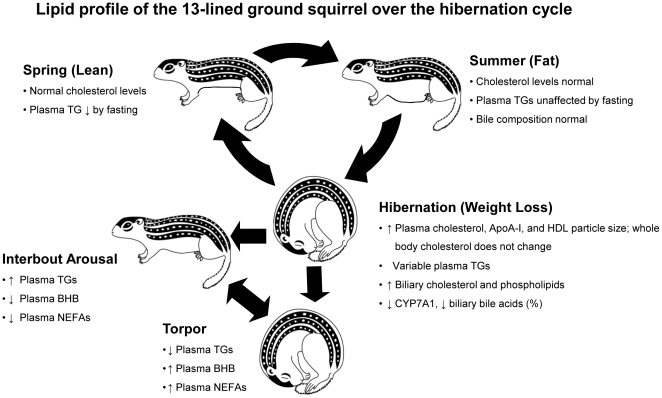
Schema of the metabolic profile of the 13-lined ground squirrel over the annual hibernation cycle.Abbreviations: TG, triglyceride, ApoA-I, apolipoproteinA-I, LT, late torpor, ET, early torpor, IBA, interbout arousal, CYP7A1, cholesterol 7 alpha-hydroxylase; BHB, β-hydroxybutyrate.